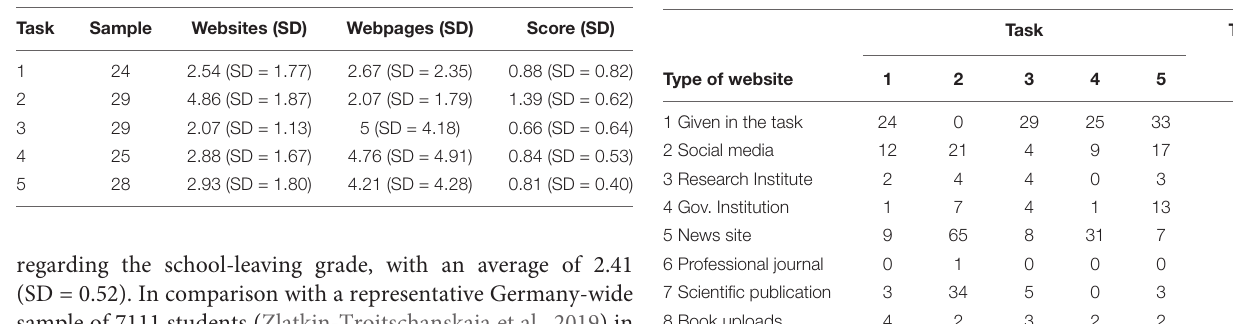
TABLE 1 | Average number of visited websites and webpages per task. TABLE 2 | Number of accessed websites by website type and per task 1